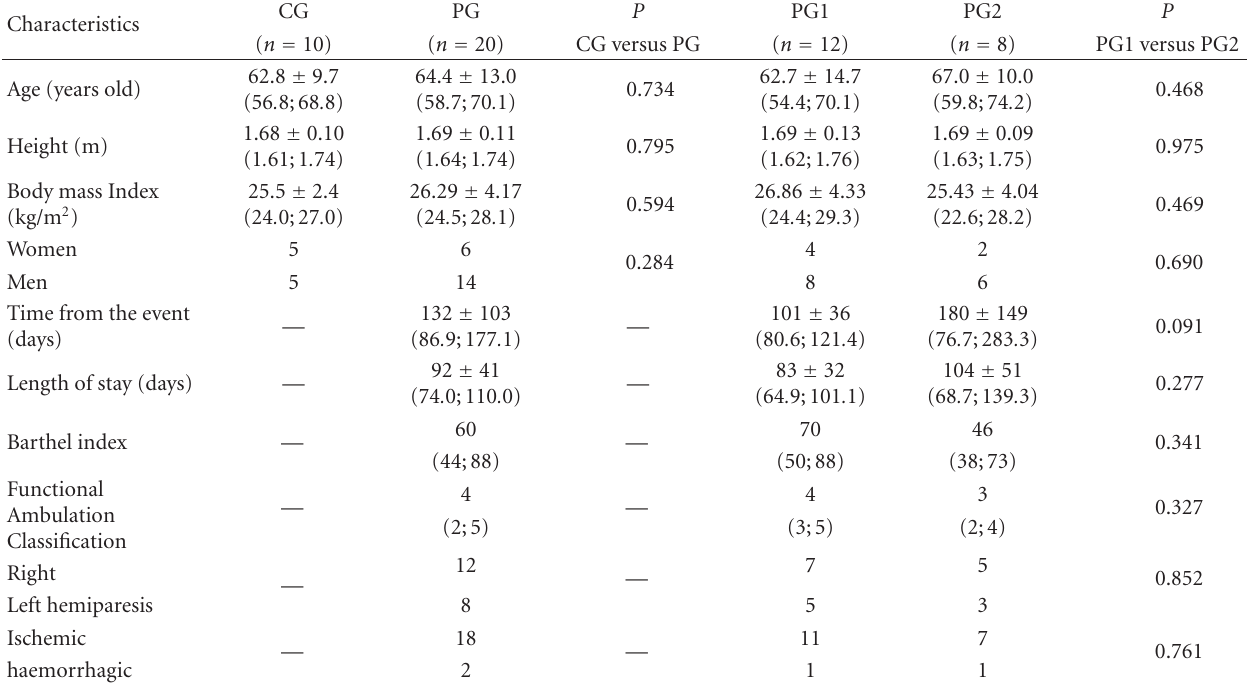
Table 1: Demographic and clinical characteristics of participants. Mean ± standard deviation (95% confidence interval) or median (first and third quartiles) of demographic characteristics, clinical features and scale scores at the moment of the 6MWT. The fourth and the last columns report the P values obtained by t test for continuous measures, Mann-Whitney u test for BI and FAC, and χ 2 test for side of hemiparesis and types of